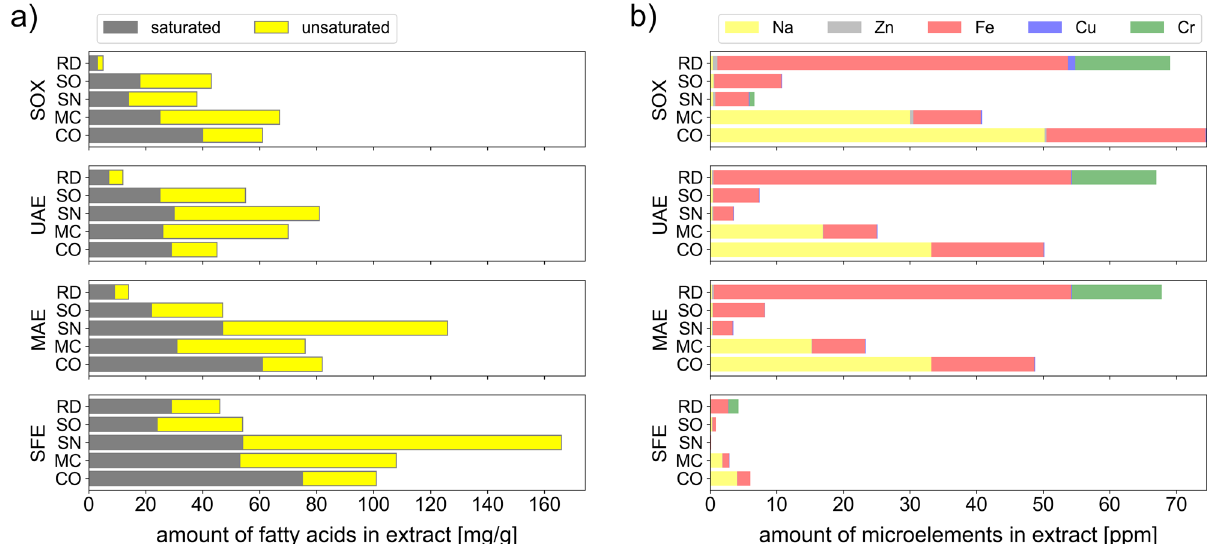
Figure 4. Additional information concerning the chemical composition of plant extracts obtained using different methods. ( a ) Amount of saturated and unsaturated fatty acids. ( b ) Amount of microelements. Error bars are omitted for clarity. All results (triplicate for each extract) were within ± 5% of each other. Precise, tabularized data are available in the Supplementary seen by the results obtained for SN-UAE and SN-SFE. The low total yield of the SN-SFE, together with its high fatty acid and flavonoid content, leaves little room for essential oil, which is also supported by the literature 13 . On the other hand, the assay results and the efficiency of C. officinalis extraction suggest that the content of retinoids in this plant material is appreciably high. Comparable in vitro radical scavenging activities of CO- SOX and CO-SFE indicate that a significant amount of redox-active compounds contained in calendula are